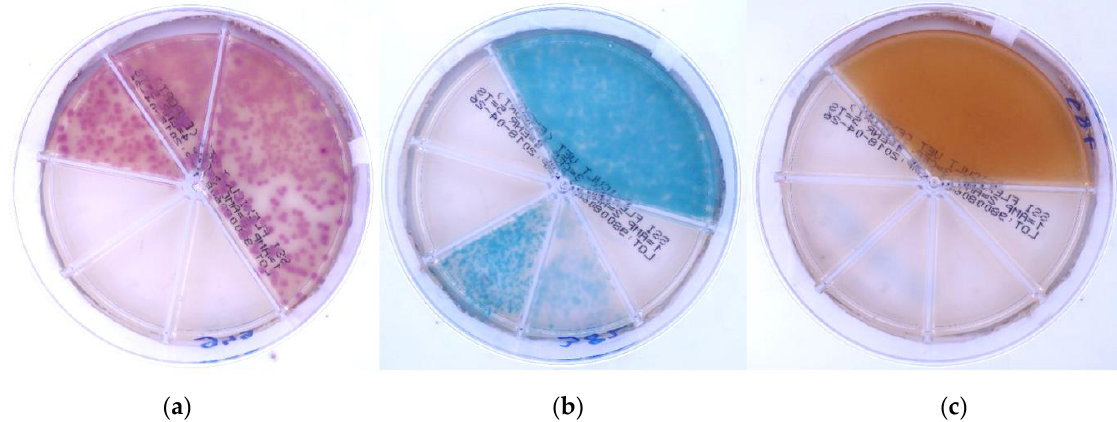
Figure 2. Bacteria of ( a ) Escherichia coli (red), ( b ) Enetrococcus faecalis (turquoise), and ( c ) Proteus spp. (brown), exhibiting distinct colors on the Flexicult Vet agar.